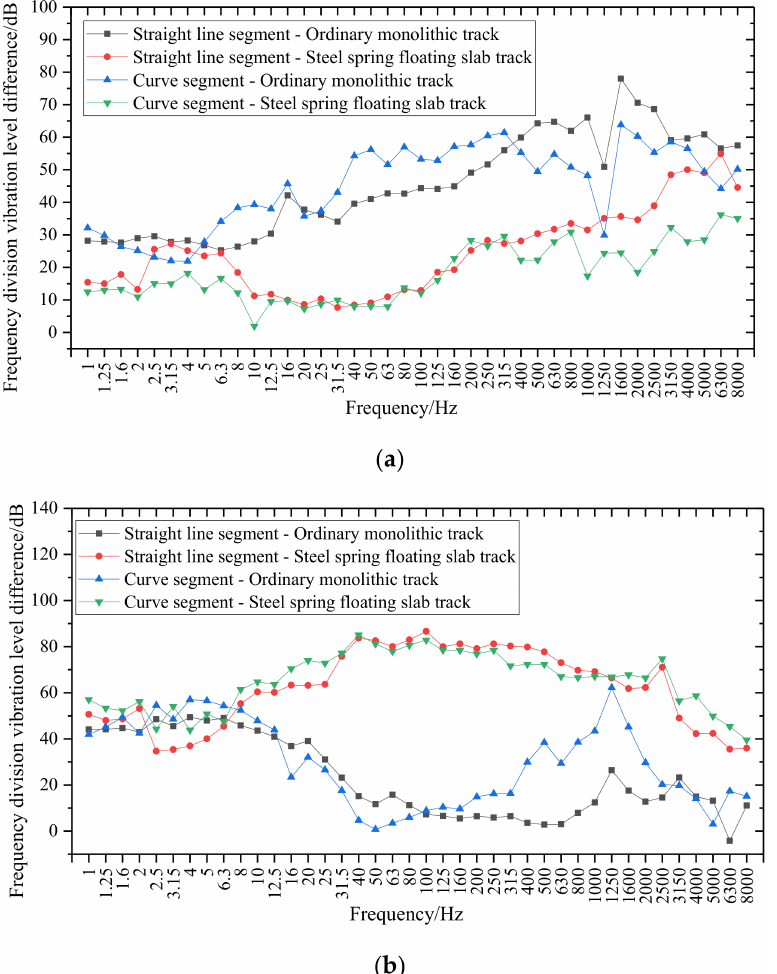
Figure 20. Comparison diagram of frequency-division vibration-level transmission difference of each track component. ( a ) Rail–track bed; ( b ) track bed–tunnel